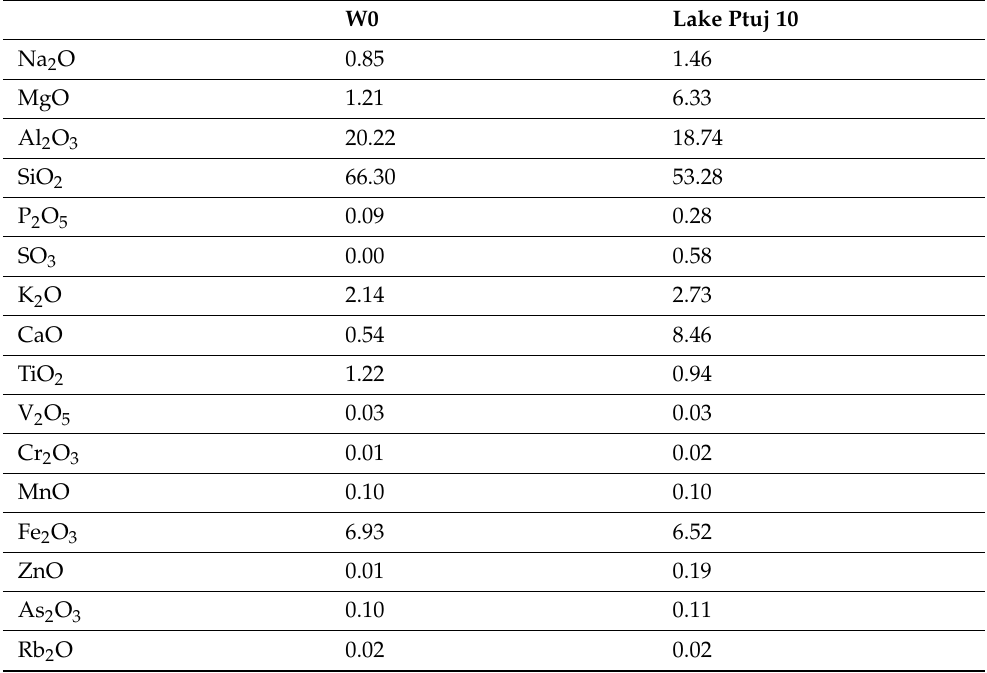
Table 2. Chemical compositions, TOC, and LOI at 550 and 950 ◦ C of the Lake Ptuj 10 sediment and the W clay used for bricks (in wt%).